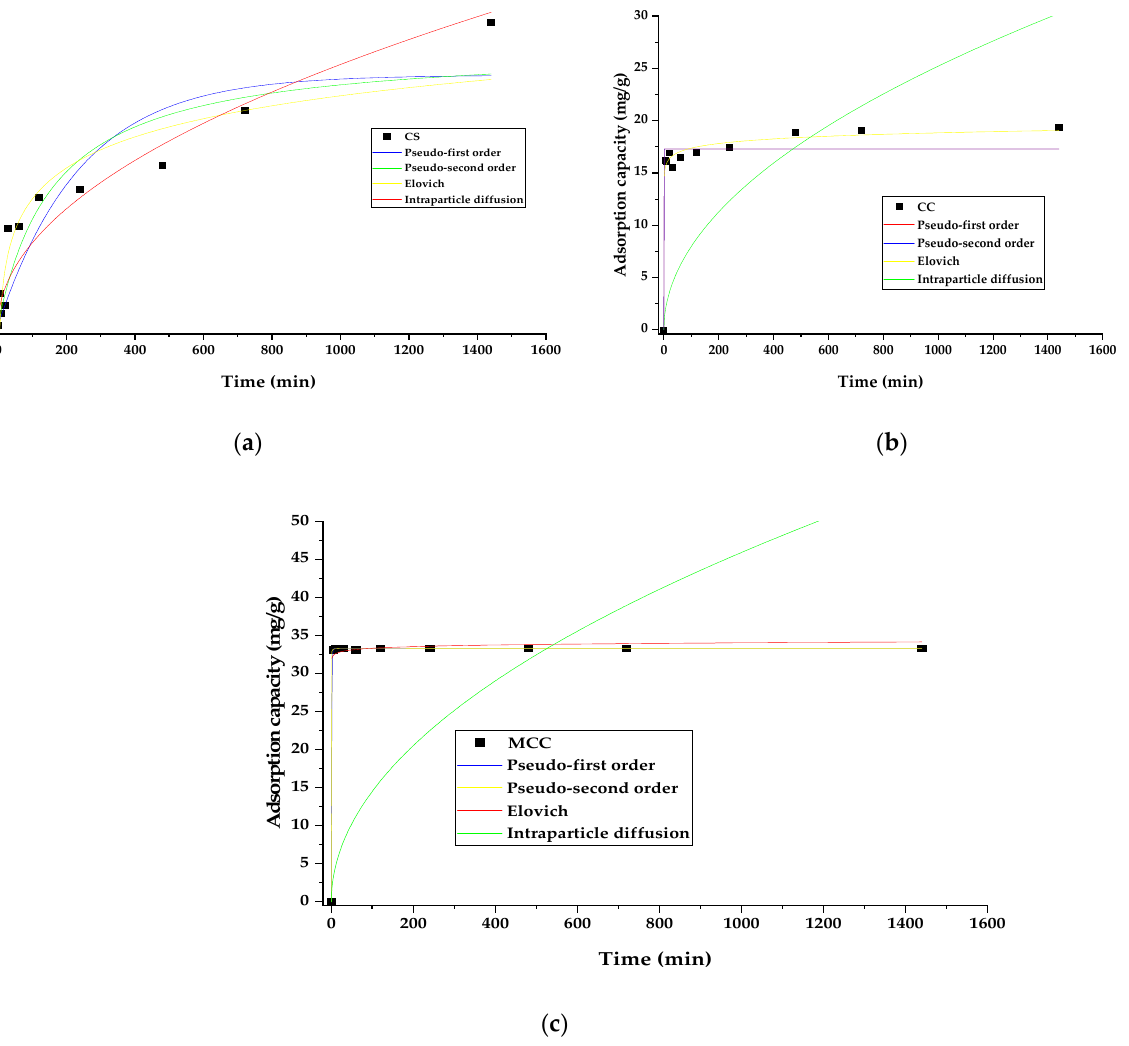
Figure 6. Non-linear fitting of RC adsorption kinetics on adsorbents from coconut mesocarp for ( a ) CS, ( b ) CC and ( c ) MCC ( a ) CS, ( b ) CC and ( c )